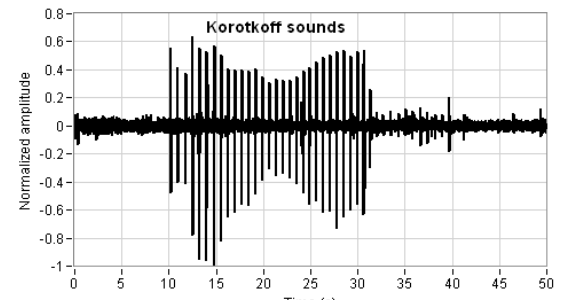
Fig. 5. Korotkoff sounds recorded by a microphone during the cuff deflation.